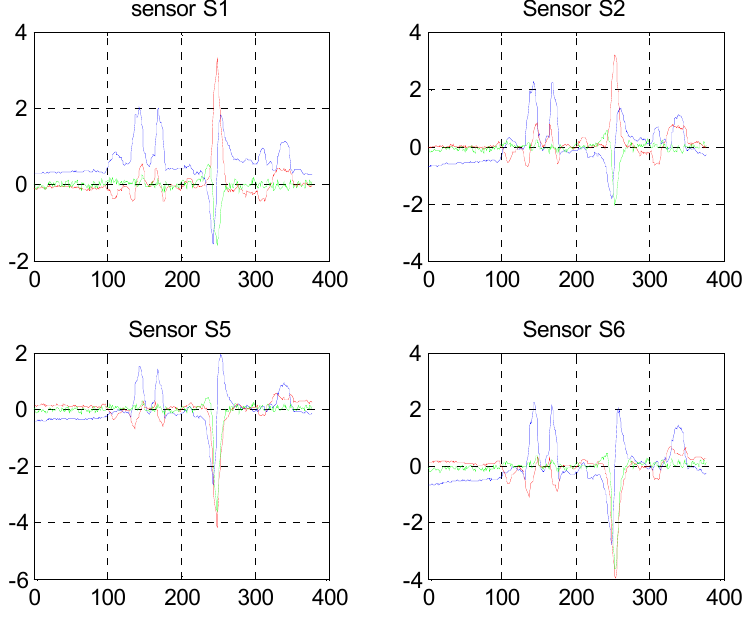
Figure 2. Magentic flux raw data of the crossing of a small metallic object in the left armpit. Units for the x axis are sample points (sp), and the y axis units are nano-Teslas